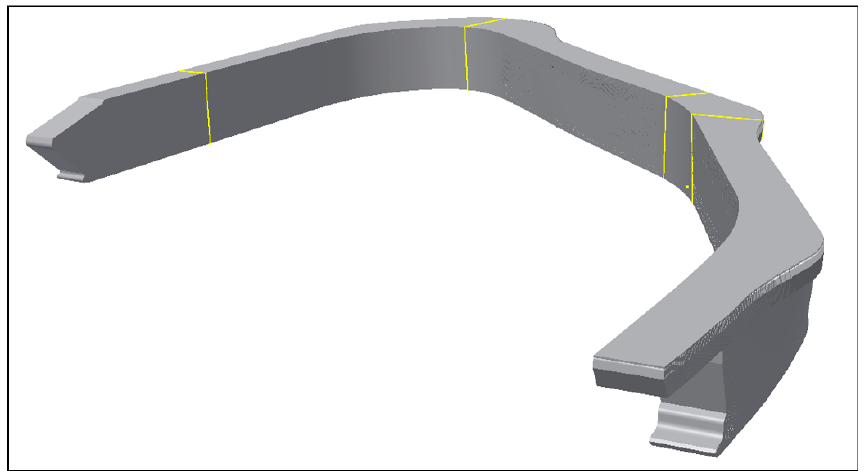
Figure 4. An example of 3D trace of transported load (output from computer simulations).